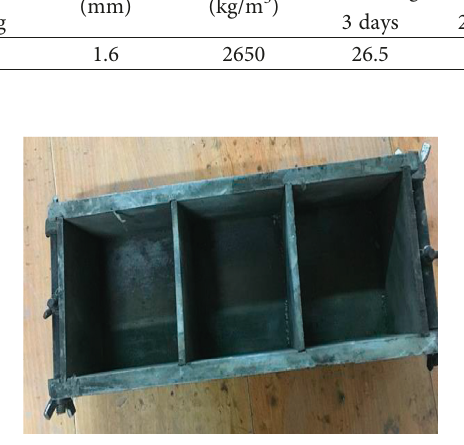
Figure 1: Cubic cast iron mold.